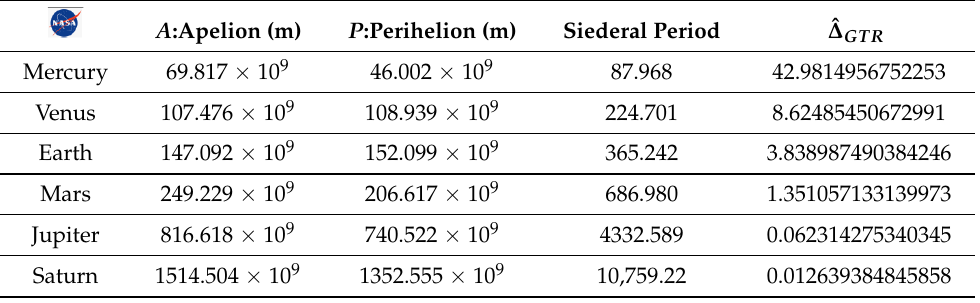
Table 3. NASA data. Table 2. Exact and Approximate Values For Perihelion Shifts Usind NASA data we got the following values for perihelion shifts :